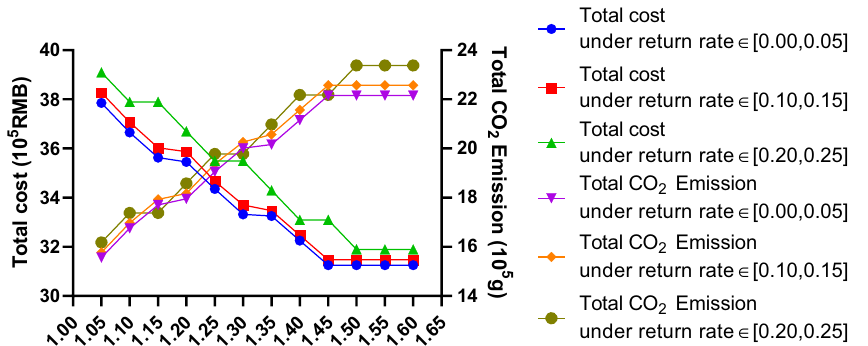
Figure 7. Pareto frontiers with